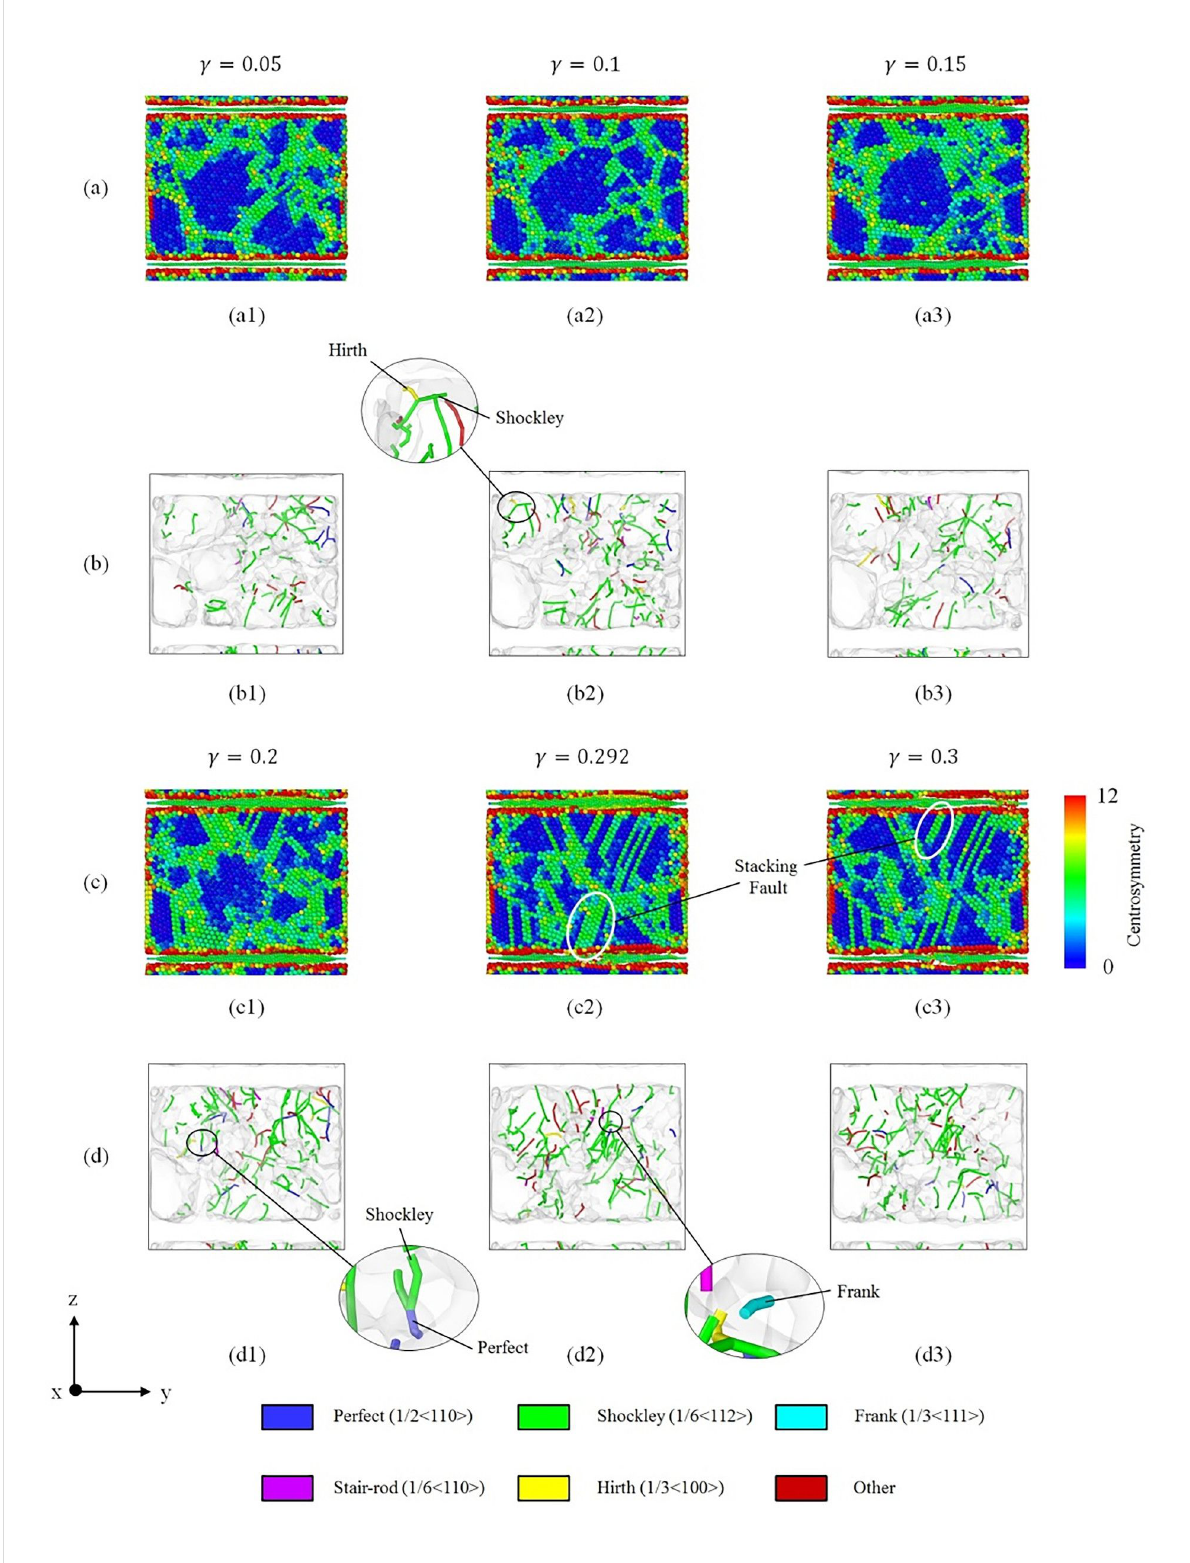
Figure 7: (a, c) Cross-sectional view of the CSP analysis of the GPCuNL composites and (b, d) DXA analysis of the dislocation evolution of the GPCuNL composites along the armchair direction at 300